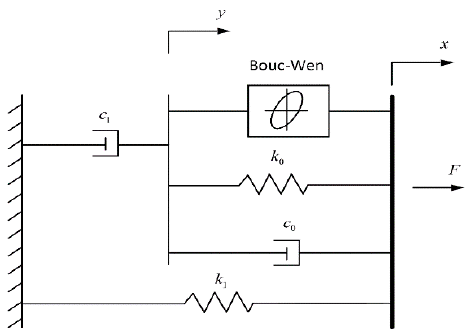
Figure 4. The structure of the improved Bouc–Wen model [13].